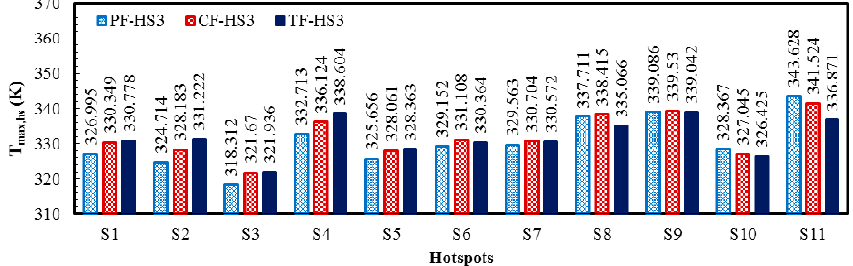
Figure 12. Maximum temperatures at the hotspots of PF, CF, and TF heat sinks with the hotspot scheme HS3 at the total flow rate of 0.01 kg/s.